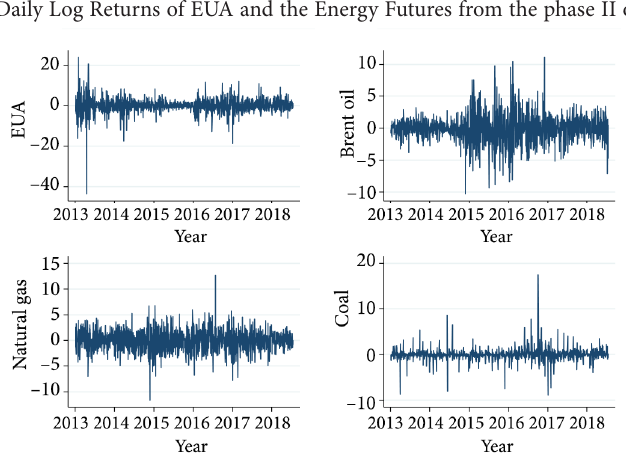
Figure 3. Daily Log Returns of EUA and the Energy Futures from the phase II of EU ETS